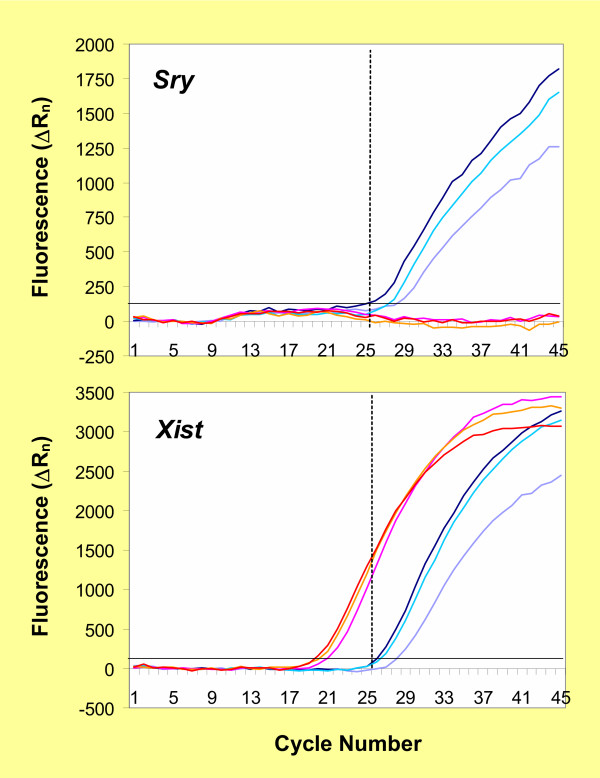
Multiplex Xist/Sry template detection in individual blastocysts processed with the single-tube PurAmp method. Sry (upper panel) and Xist (lower panel) real-time PCR plots generated by six single embryos at the blastocyst stage processed via PurAmp. All steps, starting with cell lysis, were performed by progressive dilution in the same optical-grade tube. Xist and Sry amplicons (genomic DNA plus cDNA when RNA was present) were detected simultaneously by using sequence-specific molecular beacons. Each color identifies a single embryo and is used in both panels. Female embryos (lines in red hues) were easily distinguished from male embryos (lines in blue hues) based on the presence of Xist RNA, which causes the female Xist signals to be much earlier than the male Xist signals, and on the absence of the Y-chromosome-specific Sry gene. Quantification of Xist and Sry copy numbers (given in the text) was obtained based on the CT of the real-time PCR plots (see Methods), using a genomic DNA standard curve as detailed in Fig. 2. The horizontal line in each chart indicates the threshold used to determine the CT values. The dashed vertical lines facilitate the comparison of Sry and Xist CT values in male embryos.